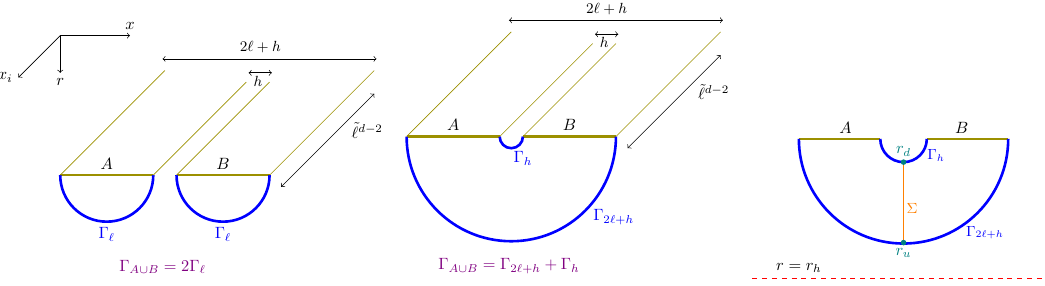
A B in disconnected (left) and connected [